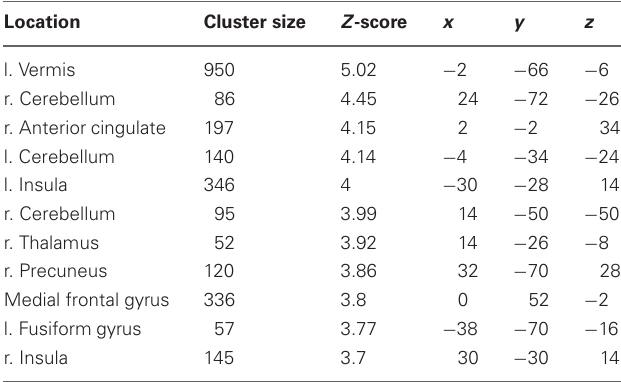
Table 1 | Locations, significance (at p < 0 . 05 FWE-corr.), and MNI coordinates for the negative group correlation between BOLD in Imitate and the speed bias (14